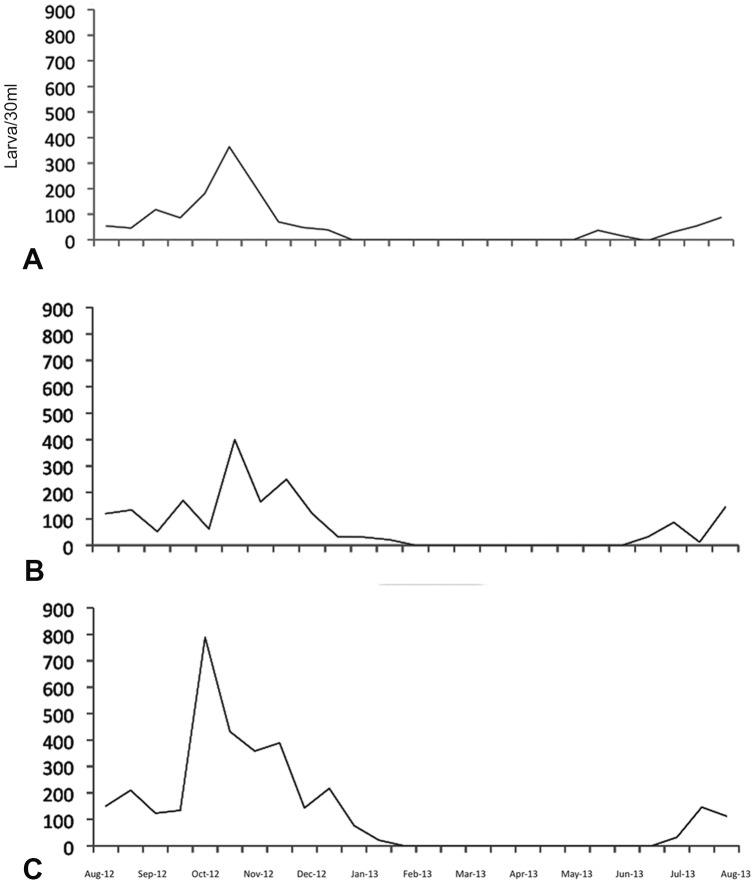
Seasonal C. sonorensis abundance for first and second (A), third (B), and fourth (C) instars.